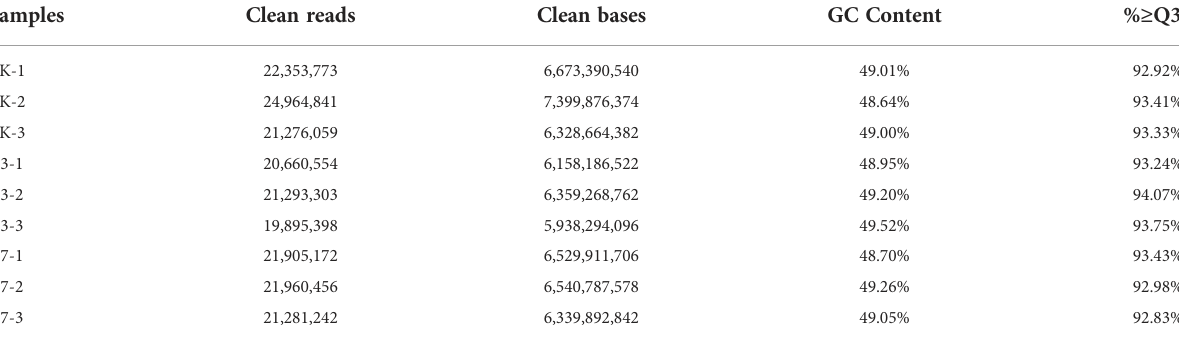
TABLE 1 Characteristics of the reads from nine sample libraries derived from the spleens of Flavobacterium psychrophilum – challenged and mock-challenged rainbow